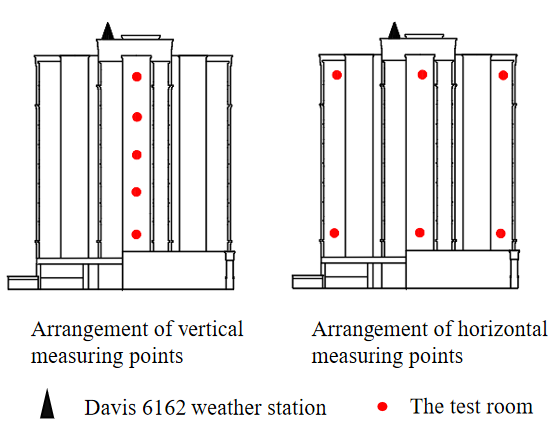
Figure 4. Test room diagram in summer.